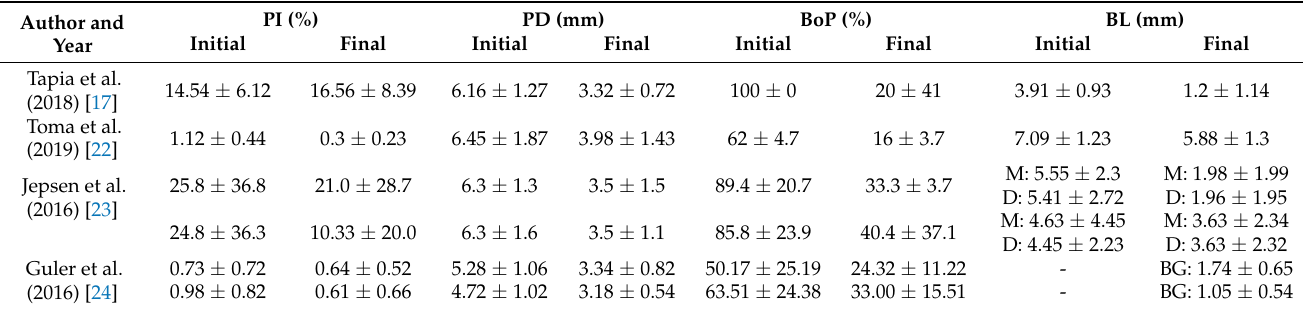
Table 3. Synthesis of the methodology and results of the studies included in the review: quantitative